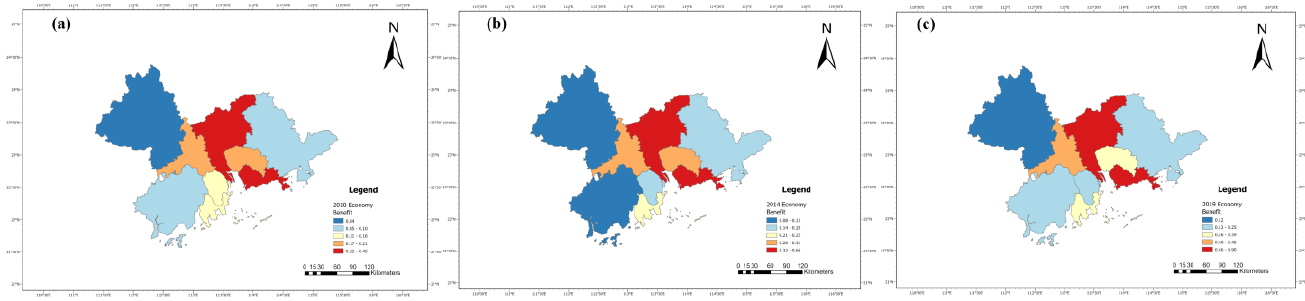
Figure 8. The benefit index of the economic development system in the PRD in ( a ) 2010, ( b ) 2014, and ( c ) 2019. ( c )